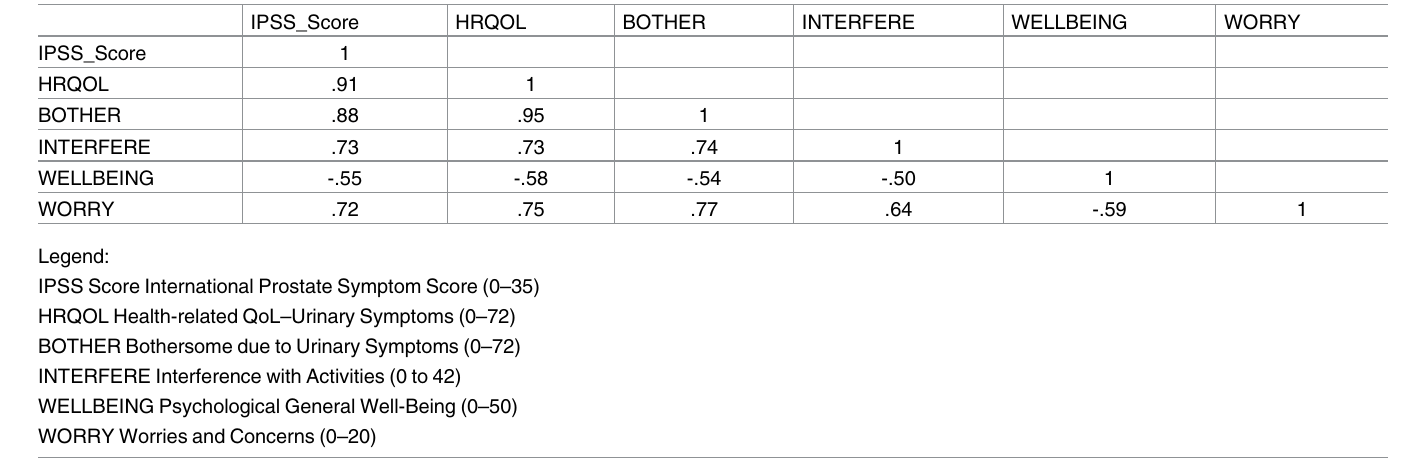
Table 4. Pairwise correlations of scale